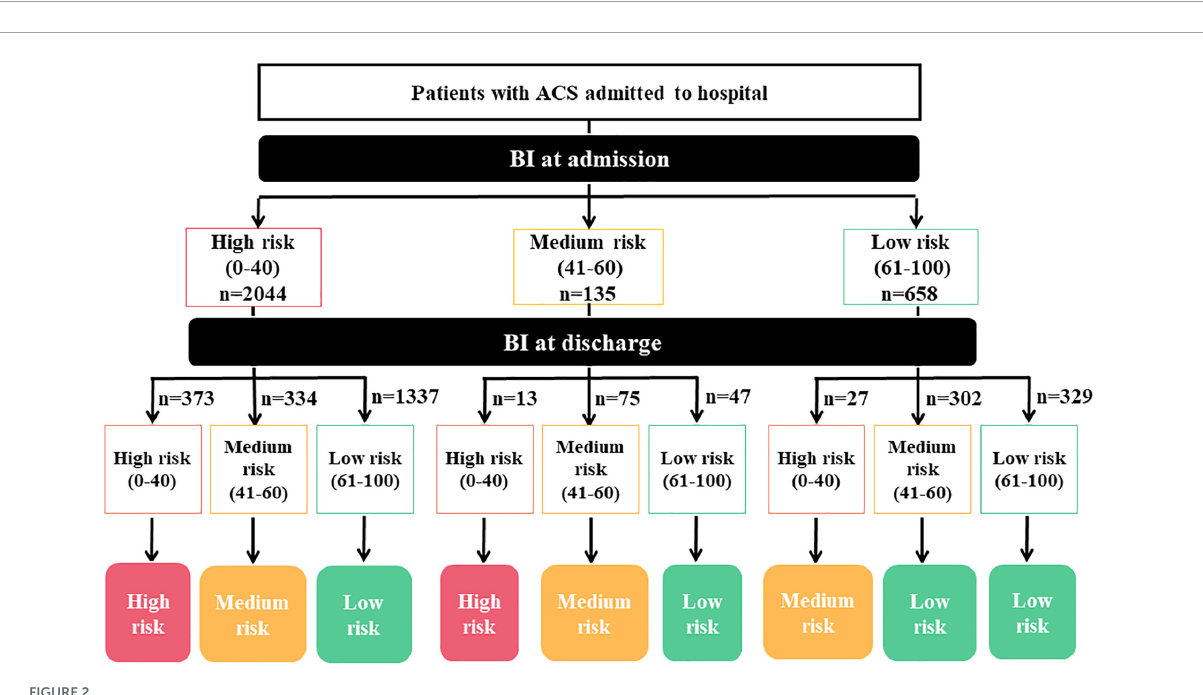
FIGURE2 Diagram of the detailed rules for dynamic BI-based risk stratification. BI, Barthel